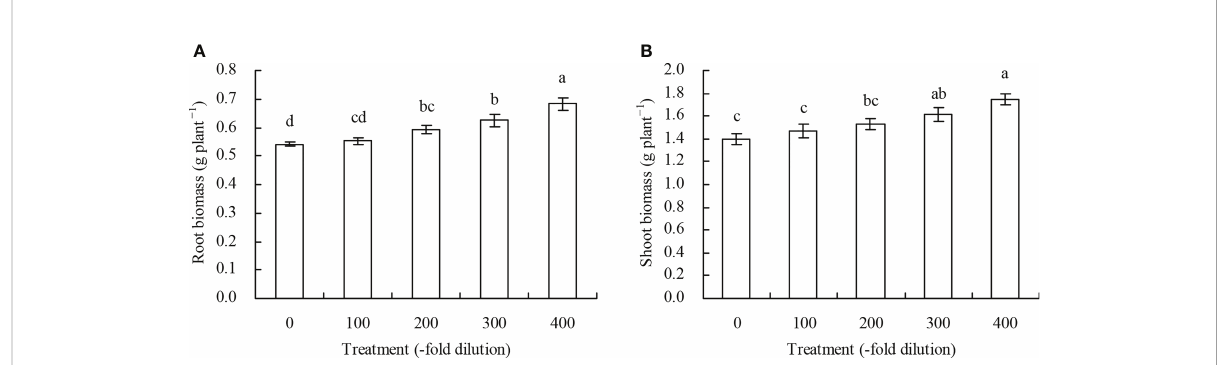
FIGURE 1 Biomass of peach seedlings. (A) : root biomass; (B) : shoot biomass. Values are means ± SD of three replicates. Different lowercase letters indicate signi fi cant differences among the treatments (Duncan ’ s Multiple Range Test, P <